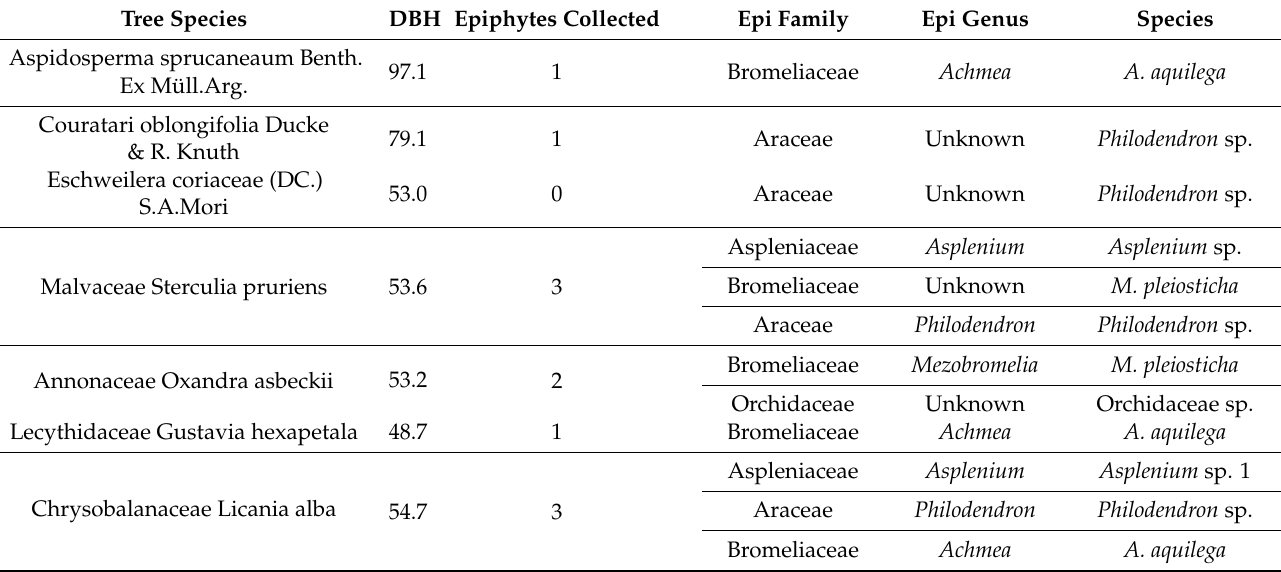
Table 3. List of all collected vascular epiphytes of canopy soil attached to their base. The family to which the epiphyte belonged and, whenever possible, the genus and species are listed. Epiphytes are given by the identified tree species. We collected epiphytes from 13 out of the 14 sampled trees. Asplenium ( Asplenium serratum ), Bromeliaceae ( Aechmea aquilega and Mezobromelia pleiosticha ), Araceae ( Anthurium sp. and Philodendron sp.), and Orchidaceae were sampled. Tree